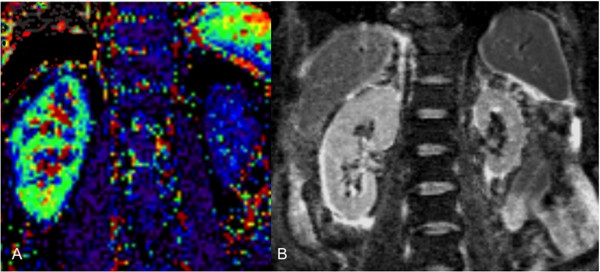
A color coded ASL as well as an ADC map are demonstrated in a patient with a shrunken, fibrotic left kidney due to ischemia. In this case, the ASL color coded map illustrates reduced perfusion compared to the contralateral, un-affected kidney, whereas the ADC map shows restricted diffusion. Arterial spin labeling measurements of renal perfusion have not yet been widely accepted into routine clinical practice. The principle dilemma with ASL-techniques is the inherently low signal intensity. The technique is also prone to susceptibility artifacts. Courtesy of PD Dr. Blondin, University of Dusseldorf.